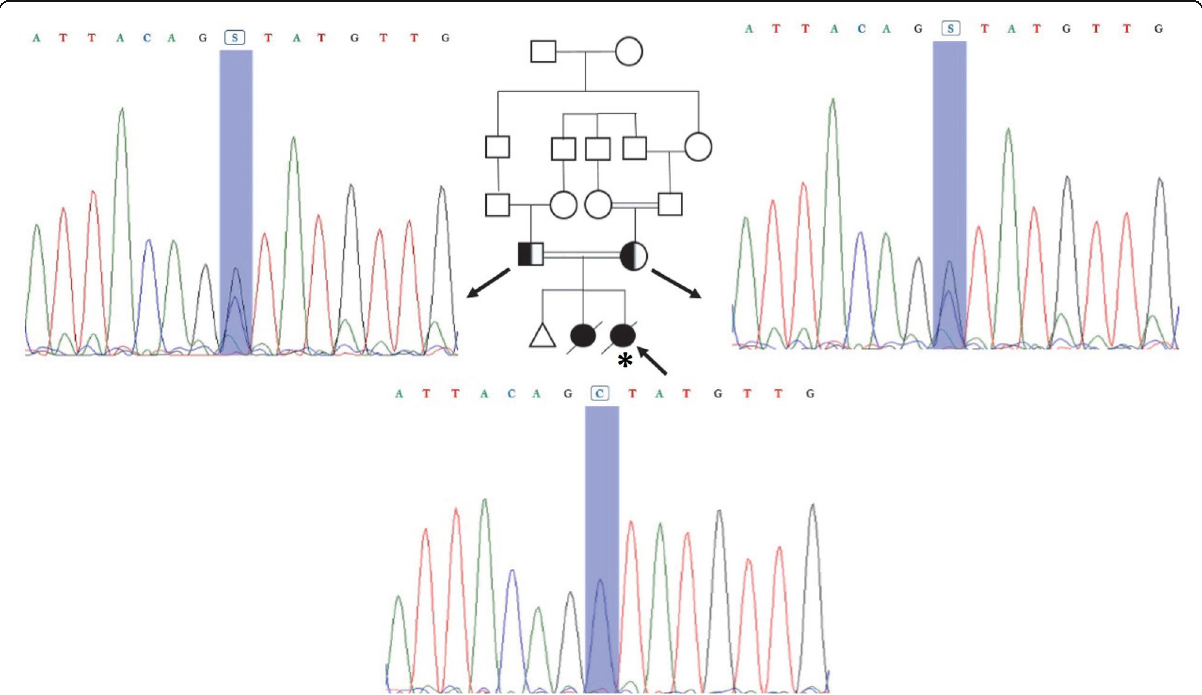
Fig. 3 Family II pedigree and sequence chromatograms. Both parents are heterozygous and the affected individual is homozygous for this mutation in MPV17 gene. The proband is marked by an asterisk